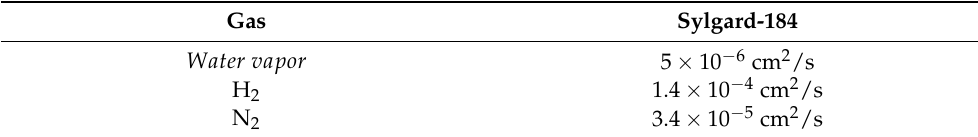
Table 1. Molecule diffusivities in Sylgard-184 [27].